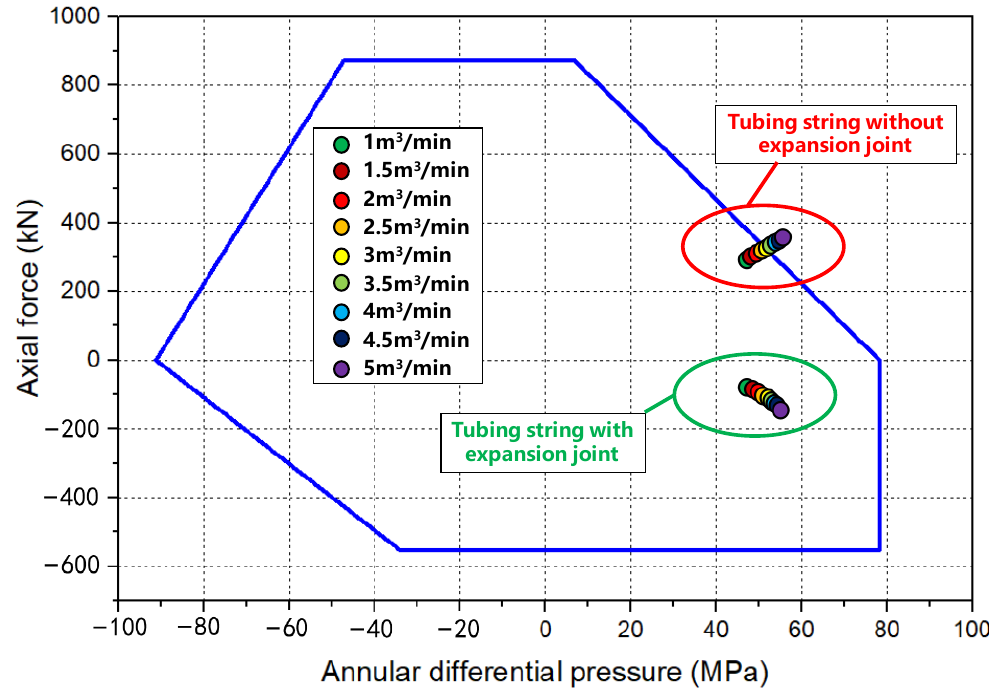
Figure 13. The axial force and annular differential pressure on the packer under different injection rates compared with the packer envelope.